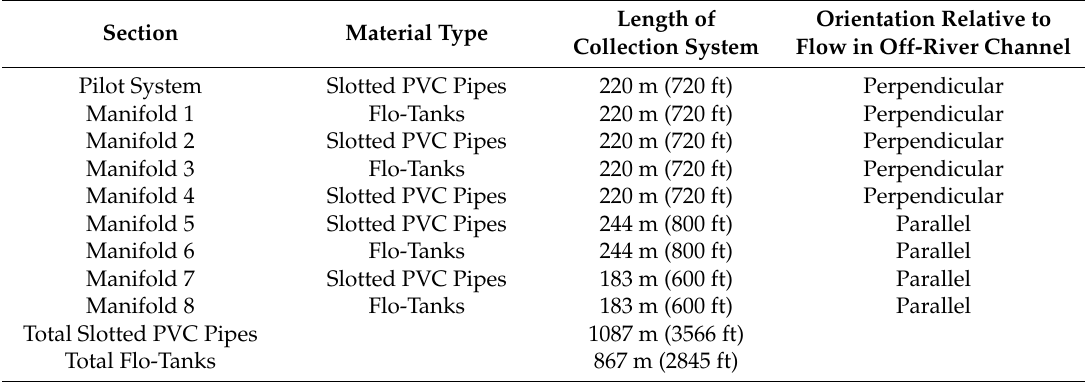
Table 1. Riverbed Filtration System (RFS) Construction